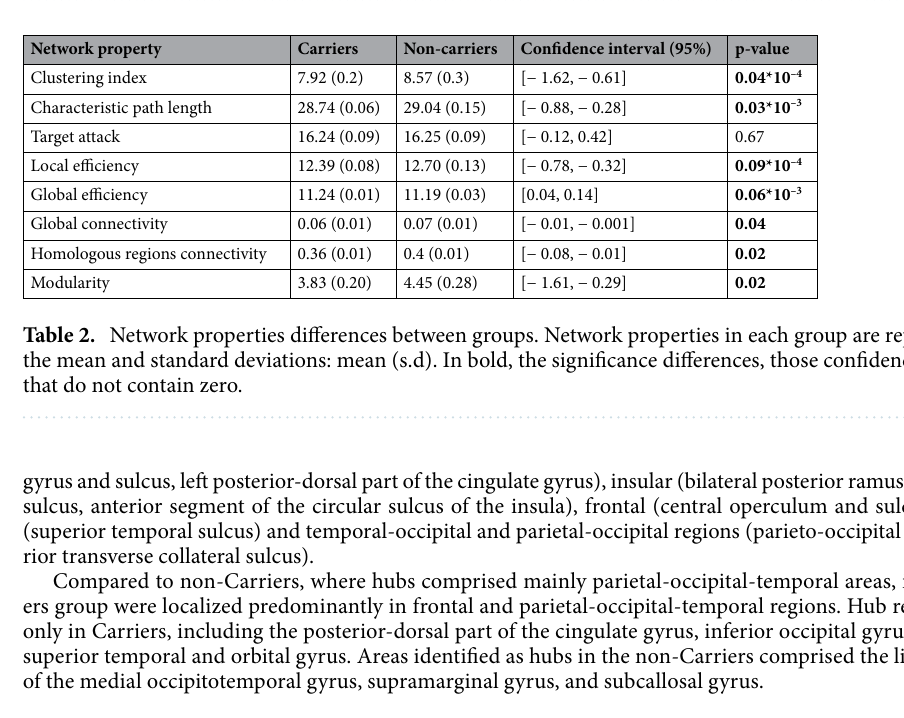
Figure 4. Global network properties as a function of sparsity degrees.